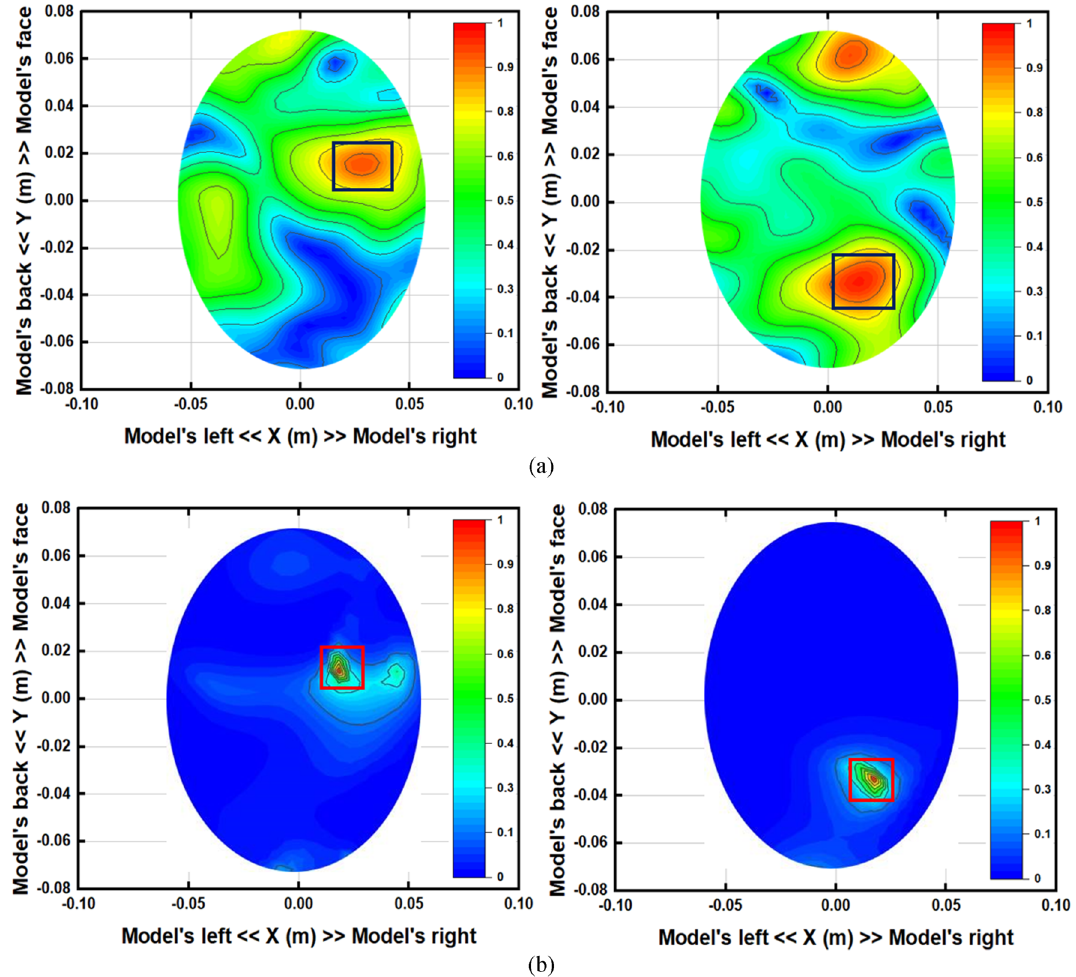
Figure 24. The reconstructed images using the proposed antenna in two different positions. ( a ) Applying conventional DMAS and ( b ) applying IC-CF-DMAS. The small red square marks the inserted hemorrhage.